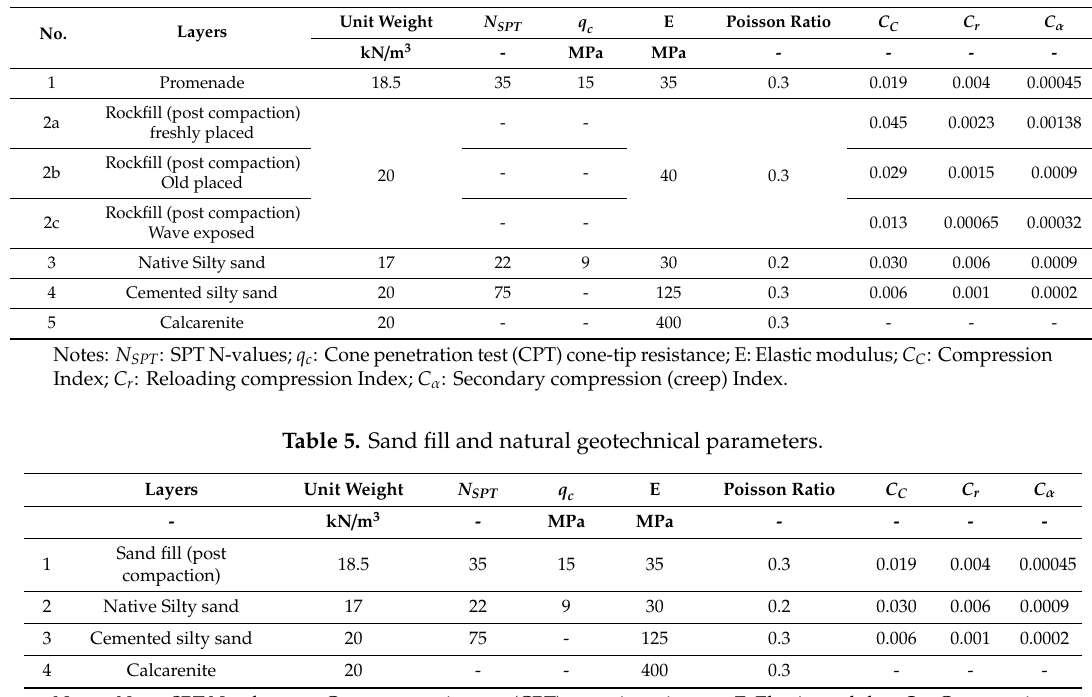
Table 4. Rockfill and natural geotechnical parameters in the three studied zones (freshly placed, old placed, and wave-exposed).